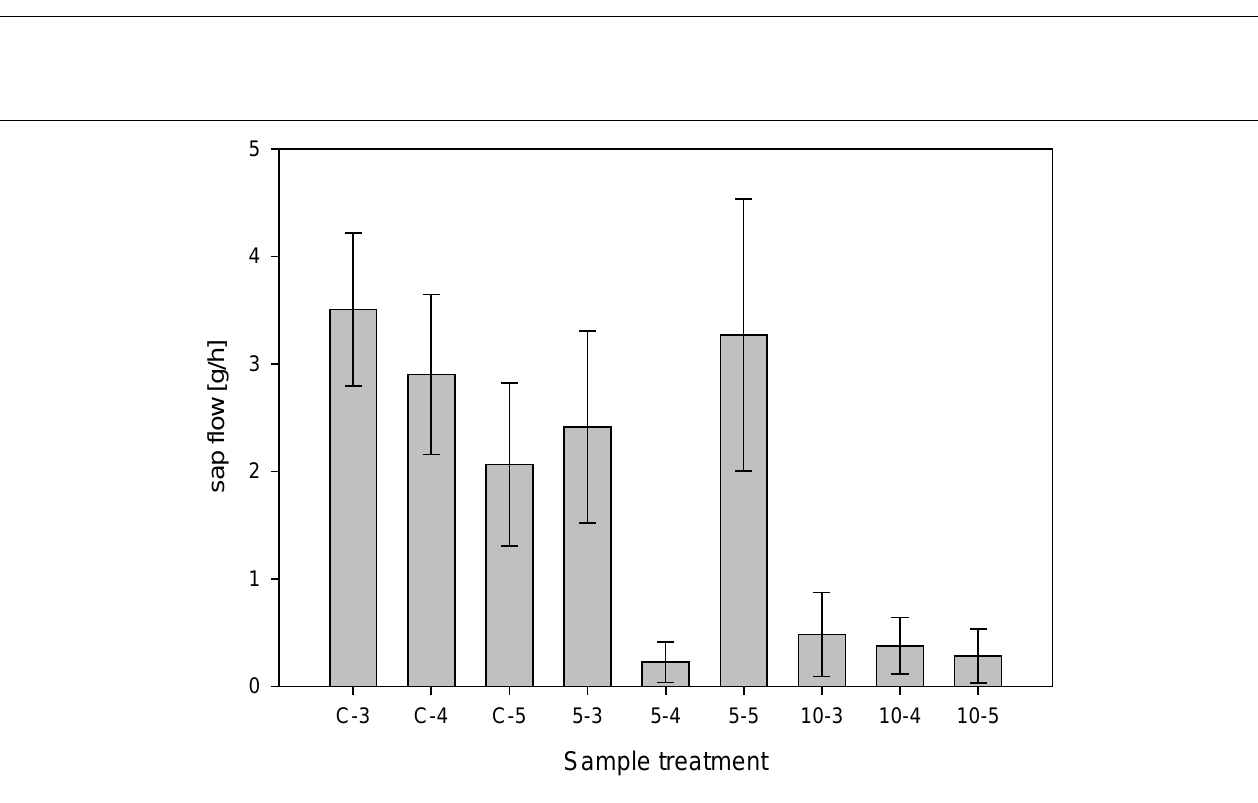
FIGUREA3 | Dendrogram of the data points in PCA score plot of plant setA using two clusters, calculated by using the Euclidean distance with complete linkage.